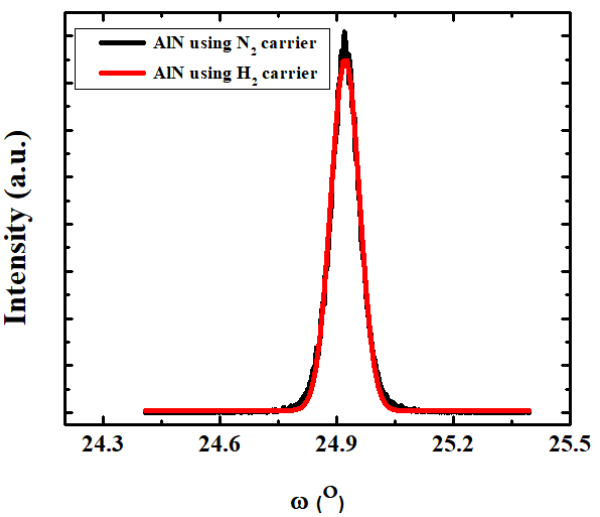
Figure 4. X-ray rocking curve of (10–12) plane for AlN sample grown in different carrier gases.